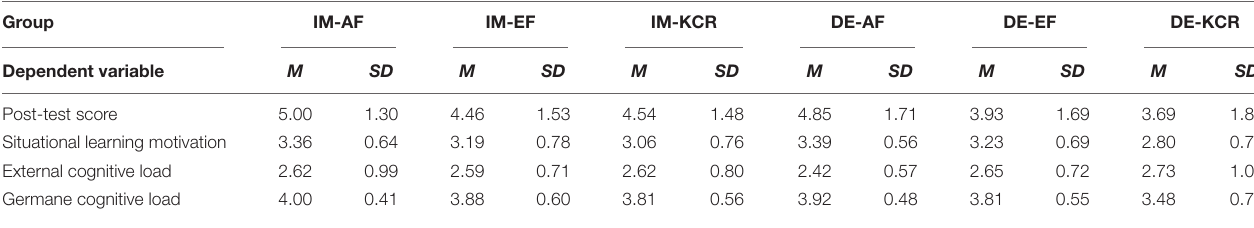
TABLE 2 | Descriptive statistical